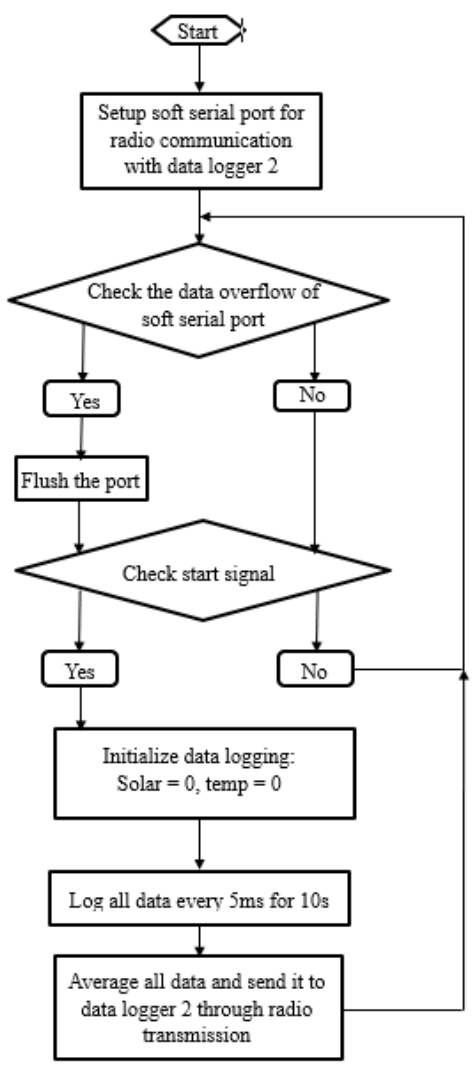
Figure 13. Program flow chart of data logger 1.